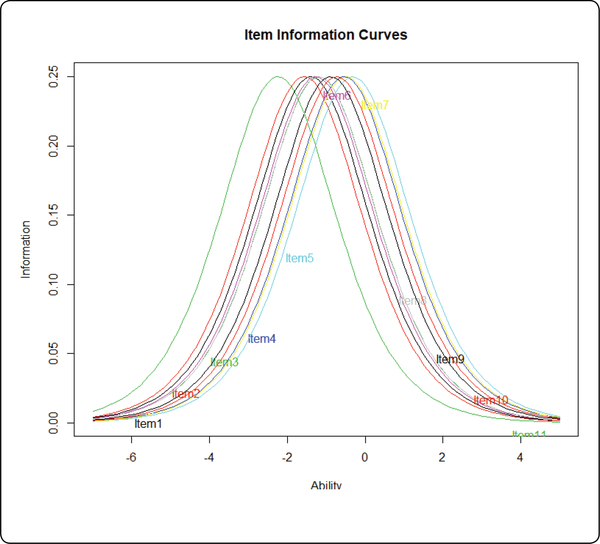
Item Information.